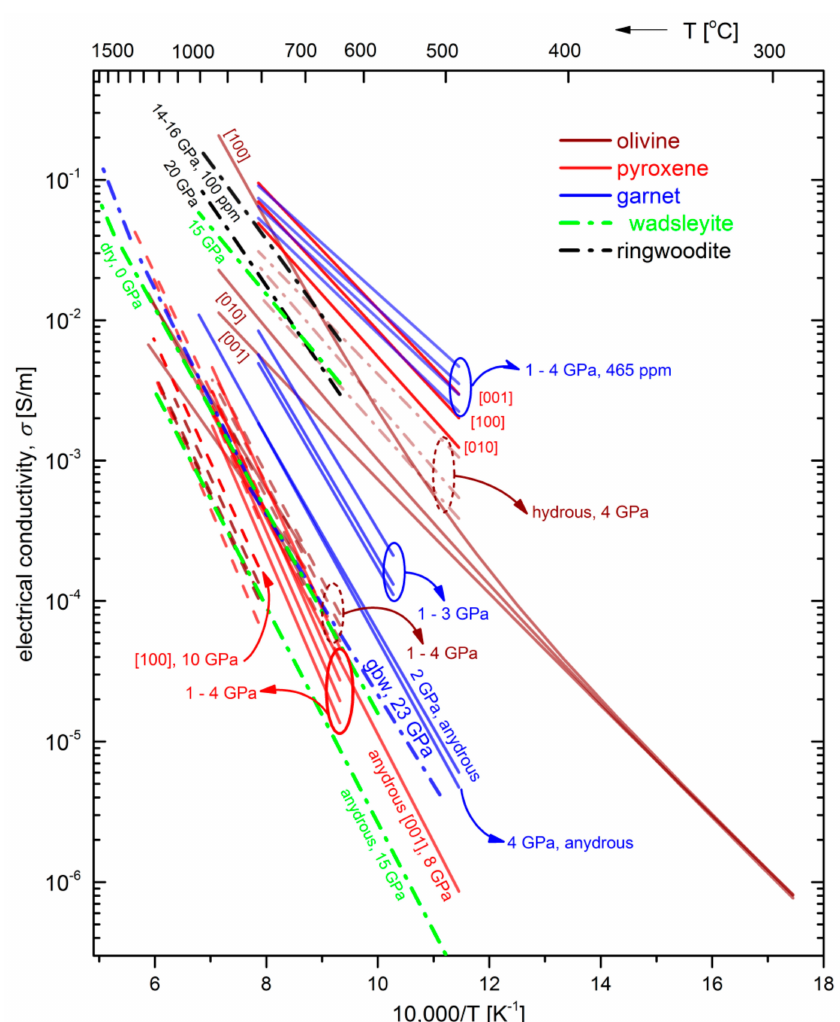
Figure 12. Arrhenius plot of EC of the major minerals in the upper mantle and the transition zone of Earth. The calculated parameters of the fitting lines are summarized in Table 1. The fitting lines are limited to the measured temperature and pressure ranges, without any extrapolations. Lines of the same color correspond to a certain mineral. Not all of the data in Table 1 are depicted in this figure, because of their large overlap. Solid lines correspond to single crystals and dashed lines to polycrystalline